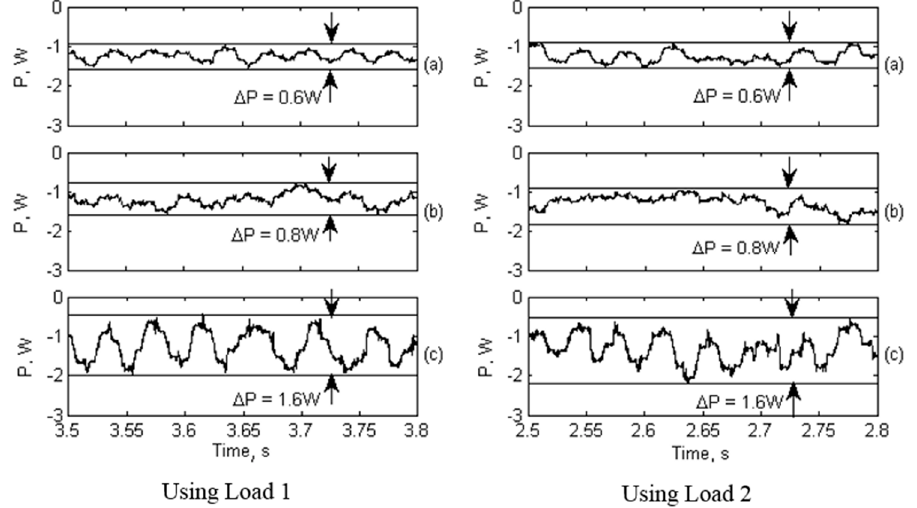
Figure 14. Real power consumed by the SAPF using Load 1 and Load 2. The SAPF applies the ( a ) Proposed, ( b ) Fuzzy ‐ PI or ( c ) Crisp ‐ PI CCA.